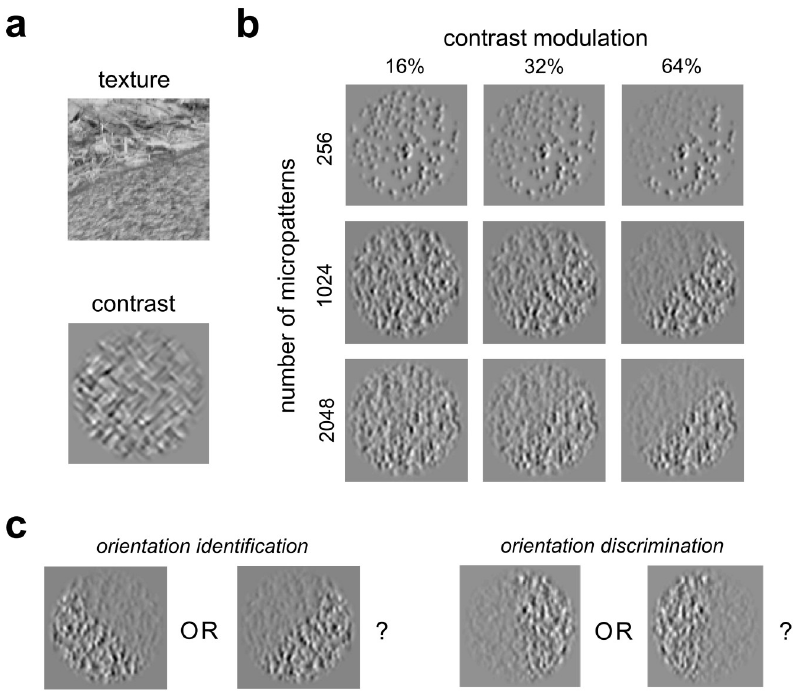
Fig 1. Examples of second-order boundary stimuli, with varying texture density and modulation depth. (a) Top : A natural occlusion boundary formed by animal fur (foreground, lower right) occluding the forest floor (background, upper left). This boundary has similar average luminance on both sides, but clearly visible differences in texture. Bottom : A contrast-defined boundary (used in Experiment 3) with identical mean luminance in each region, but different contrasts of the texture elements. In this example the contrast modulation envelope has a left-oblique (-45 deg. w.r.t vertical) orientation. (b) Examples of contrast-modulated micropattern stimuli, for three densities of micropatterns and three modulation depths, all having a right-oblique (+45 deg.) boundary orientation. Boundary segmentation is typically easier with increasing modulation depth and micropattern density. (c) Schematic illustration of the two psychophysical tasks used here ( orientation identification : Experiments 1 and 3, orientation discrimination : Experiment 2), in both cases two-alternative forced-choice judgements of left- vs. right-oblique boundary orientation. Stimuli shown are representative of those used in Experiments 1 and 2. In the identification task boundaries are oriented at (+/- 45 deg.), and in the discrimination task boundaries are oriented slightly off vertical (+/- 6–7 deg.).